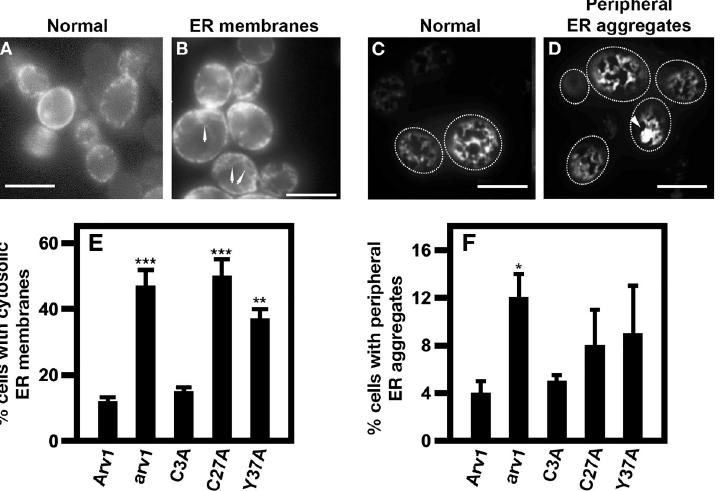
Fig 10. Scarv1 cells expressing ScArv1 C27A accumulates cytosolic ER membrane structures. S . cerevisiae cells were grown in the appropriate plasmid selection medium. Cells were transformed with YCplac111-RTN2-GFP (RTN2